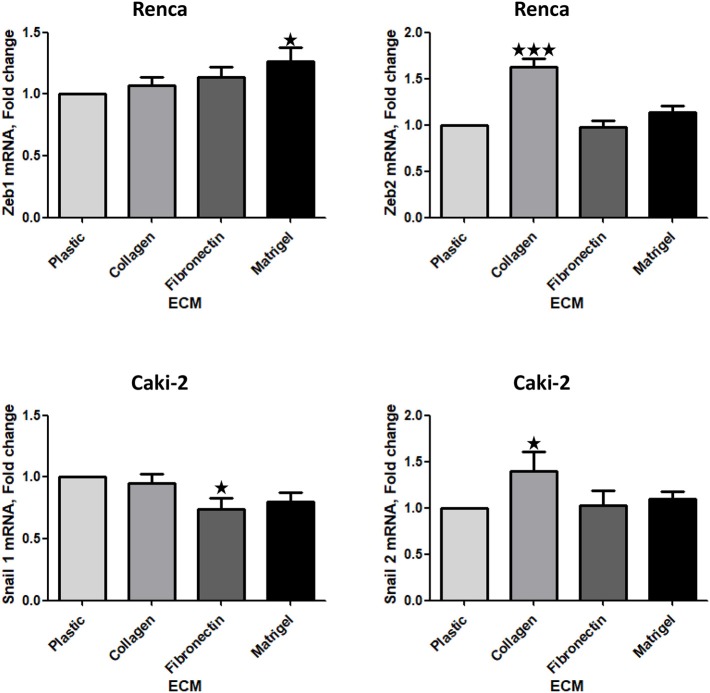
Effect of the different ECM components on the expression of transcription factors implicated in EMT. Relative mRNA levels for Zeb1, Zeb2, Snail 1, and Snail 2 were assessed by RT-qPCR after 24 h of RCC cells cultured on plastic, Col 1, FN1, or Matrigel. Upper panels, Renca cells, N = 7. Lower panels, Caki-2 cells, N = 5. ⋆P < 0.05; ⋆⋆P < 0.01; ⋆⋆⋆P < 0.001.